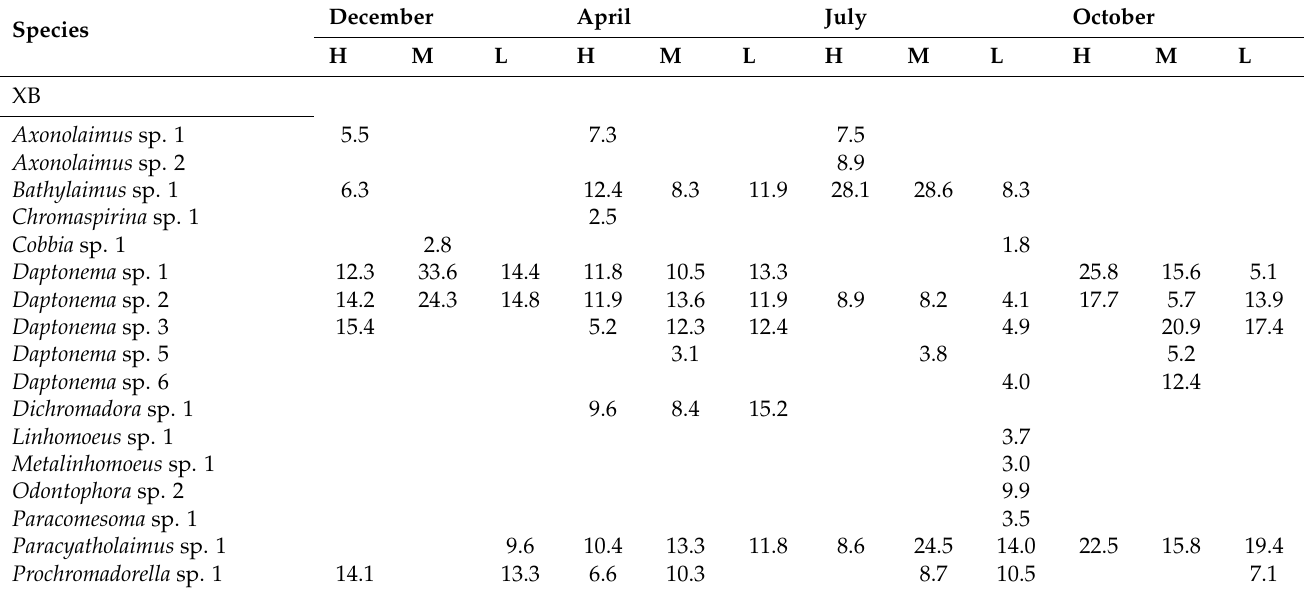
Table 3. The species primarily providing the discrimination between locations, tidal zones, and sampling months (SIMPER, cumulative contribution